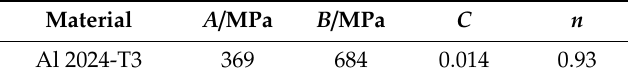
Table 1. Johnson–Cook material constants